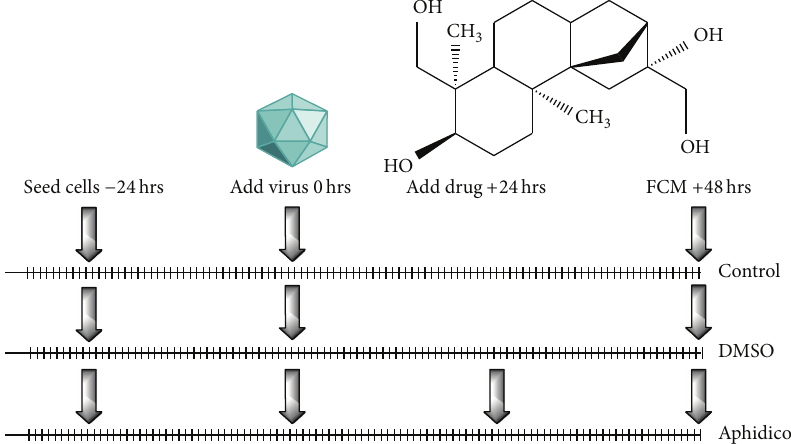
Figure 3: The timescale representation of the transduction experiments with aphidicolin substance to stop a cell cycle in G 1 /S phase. DMSO was added to the A549 cells for a toxicity evaluation and as a solvent for the